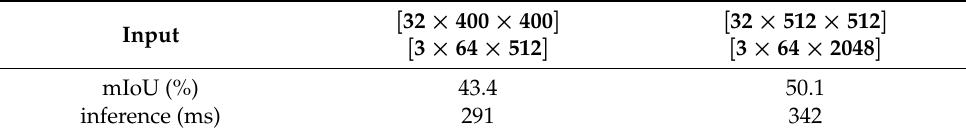
Table 5. Performance for PointNet-based fusion. Using larger projections to reduce projection error improves the performance of the fusion but is still worse than using single